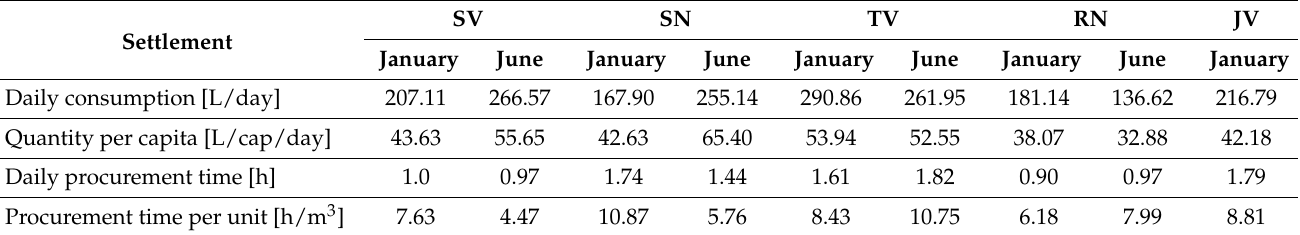
Table 3. Average water consumption quantities and procurement time by settlement. Note that days without water supply were considered in the calculation of the mean to accurately compare between settlements with and without daily supply. (Data source: